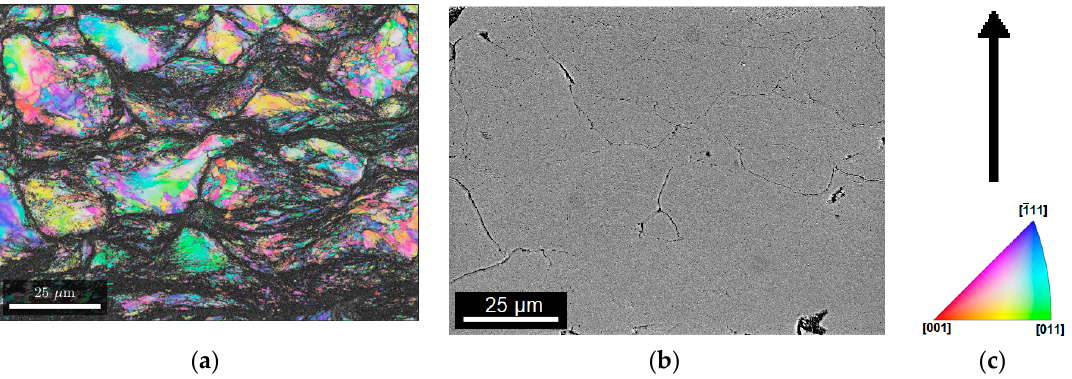
Figure 6. ( a ) Electron backscattered diffraction (EBSD) inverse pole figure (IPF) map of coating cross-section ( b ) corresponding SEM-SE image ( c ) arrow indicating particle impact direction and IPF color key.